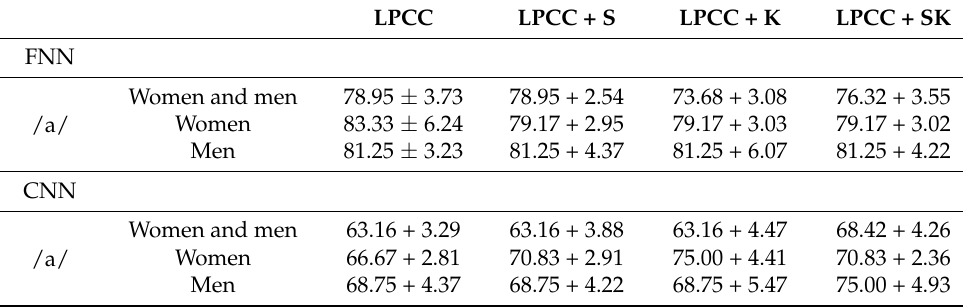
Table 6. Classification results obtained by LPCC, skewness, and kurtosis parameters and the two different deep learning